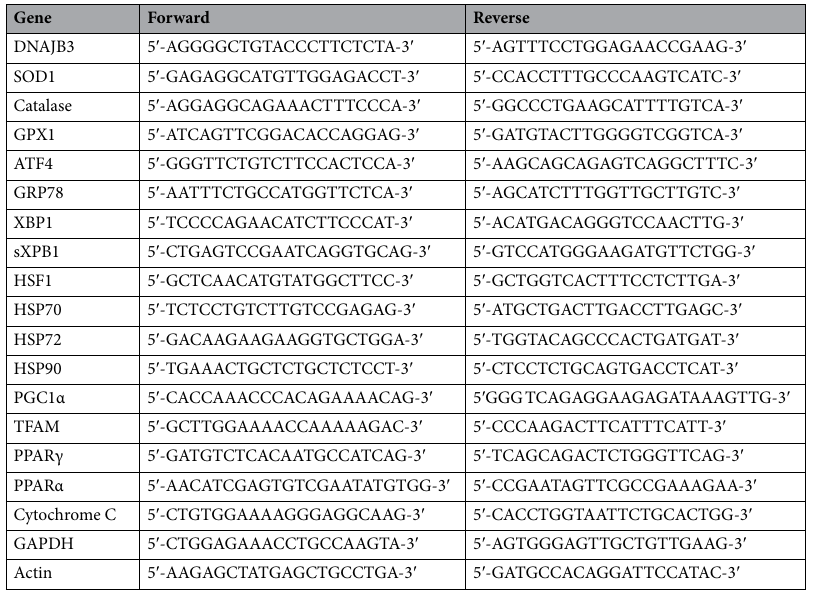
Table 2. Primer list and